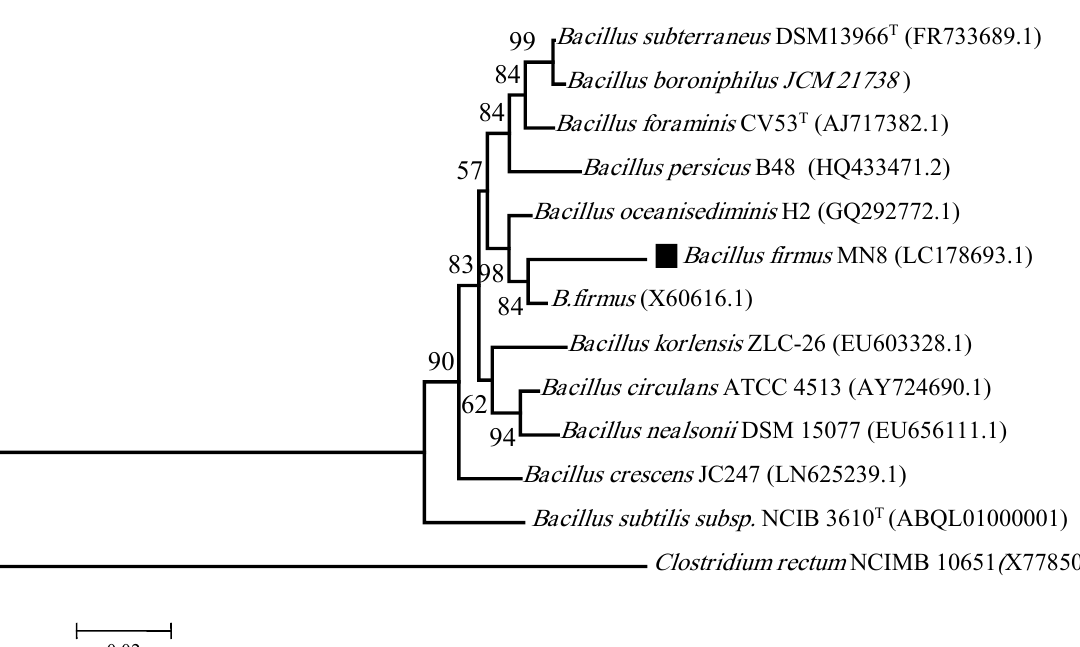
Fig. 2: Neighbor-joining tree based on 16S rRNA gene sequences. Results show the correlation between MN8 strain and its near relatives in Bacillus genus. The Clostridium rectum NCIMB 10651 sequence is out-group in the tree